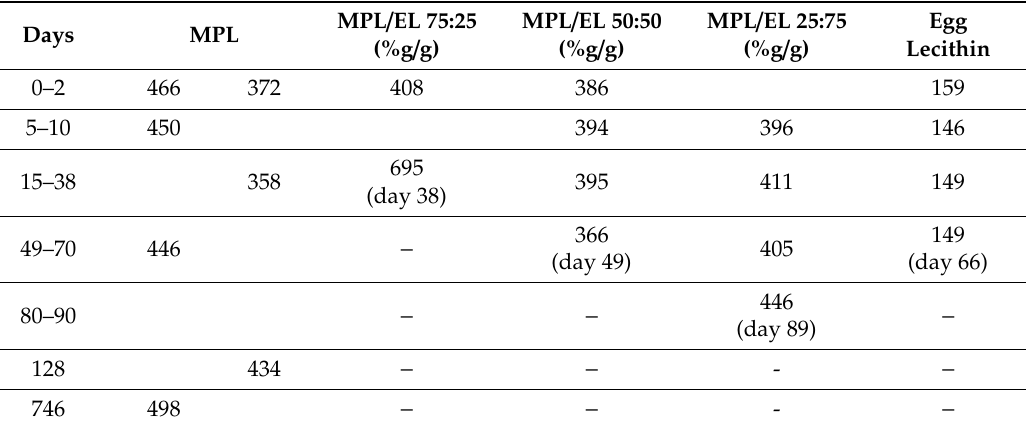
Table 11. Shelf stability of mixed liposomes, average size.